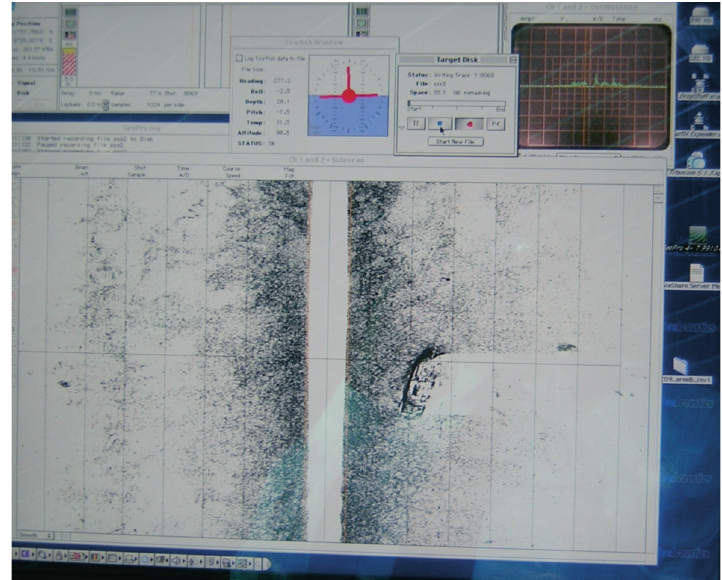
Fig. 5. Sonar images of the Equa